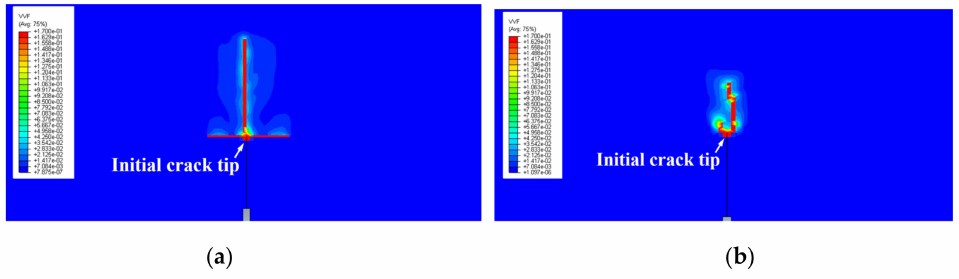
Figure 7. The crack propagation paths of all the first crack-branching models.